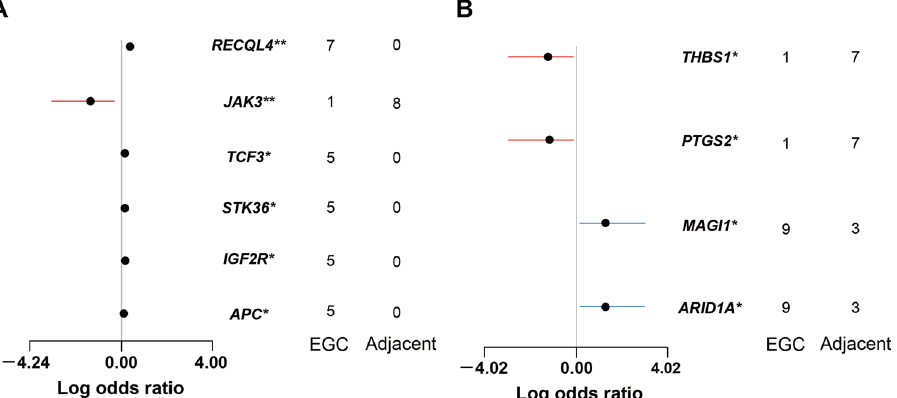
Figure 5. Specific genes harboring somatic variants associated with the initial EGC and the adjacent non- cancerous mucosa in the N group ( A ) or M group ( B ). We evaluated log odds ratios based on a false discovery rate < 0.3. *p < 0.05, **p < 0.01. RECQL4 RecQ like helicase 4, TCF3 transcription factor 3, STK36 serine/ threonine kinase 36, IGF2R insulin like growth factor 2 receptor, APC adenomatous polyposis coli, JAK3 Janus kinase 3, ARID1A AT-rich interactive domain containing protein 1A, MAGI1 membrane associated guanylate kinase WW and PDZ domain containing 1, THBS1 thrombospondin 1, PTGS2 prostaglandin-endoperoxide synthase